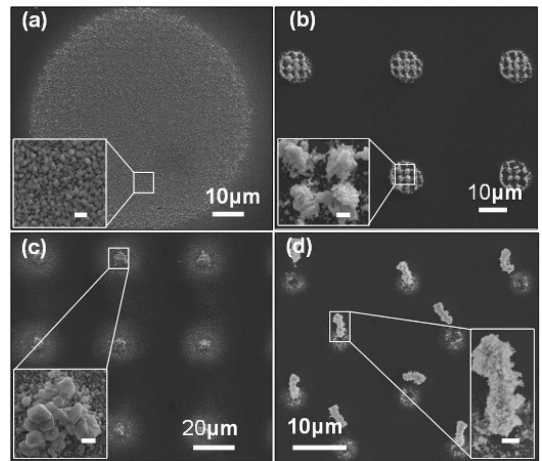
Figure 12. Synthesis of various silver nanostructures by optically-projected patterns in OEK chip. ( a ) Silver crystal nanoparticles. ( b ) Stacked silver hexagonal nanoplates. ( c ) Crystallized silver octahedra and hexagonal silver nanoplates. ( d ) An array of silver nanoparticles-based micropillars (reproduced from Ref. [77]).